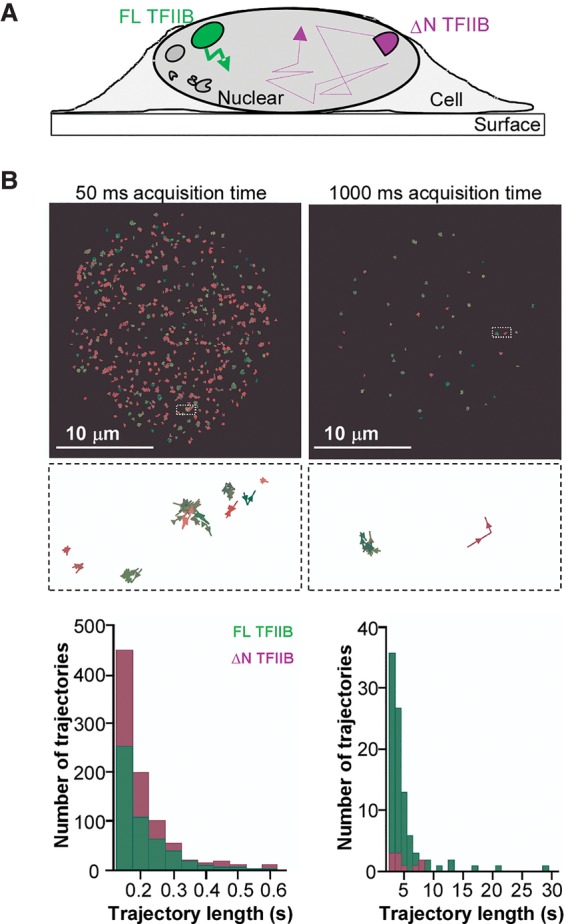
The N-terminal deletion of TFIIB increases its dynamics in live cells. (A) Scheme: Differentially labeled FL and ΔN TFIIB (false-colored in green and magenta, respectively) were introduced into cells by bead loading and imaged simultaneously within a living nucleus by single-molecule microscopy. At certain acquisition times, fast-moving molecules were blurred (thin dashed lines), while stably bound molecules were detected (thick solid lines). (B) Trajectories of FL (shades of green) and ΔN (shades of magenta) TFIIB detected by live-cell single-molecule imaging acquired with 50-msec (left) or 1000-msec (right) exposure times for a total of 100 sec. (Top) All TFIIB molecules detected in one nucleus for at least three consecutive frames were plotted as trajectories ([left] 539 FL and 923 ΔN TFIIB; [right] 93 FL and 11 ΔN TFIIB). (Middle) Insets (2 × 1-µm) highlighting example trajectories (color shades indicate different molecules). (Bottom) Histogram of all trajectories lasting three or more frames. Each trajectory was interpreted as one stable association event because the displacement was well within the diffraction limit and system variations (such as chromosome fluctuation).